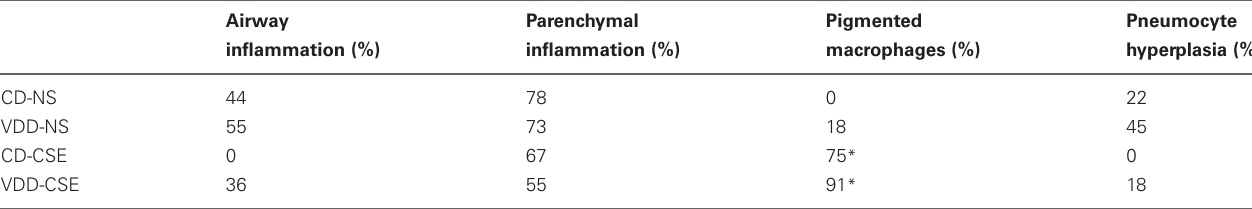
Table 2 | Histological review of mouse